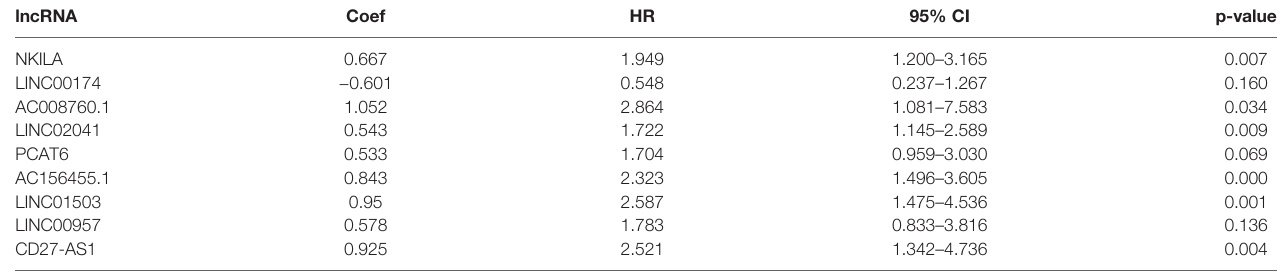
HR, hazard radio; CI, con fi dence interval.